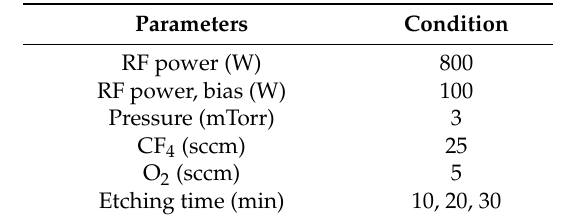
Table 2. Plasma etching